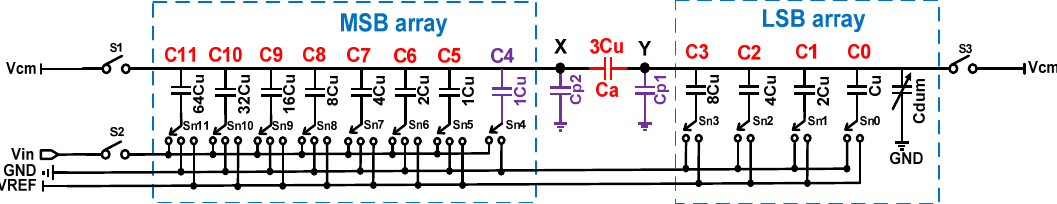
Figure 2. A-12 bit bridge DAC capacitor array with parasitic capacitance.